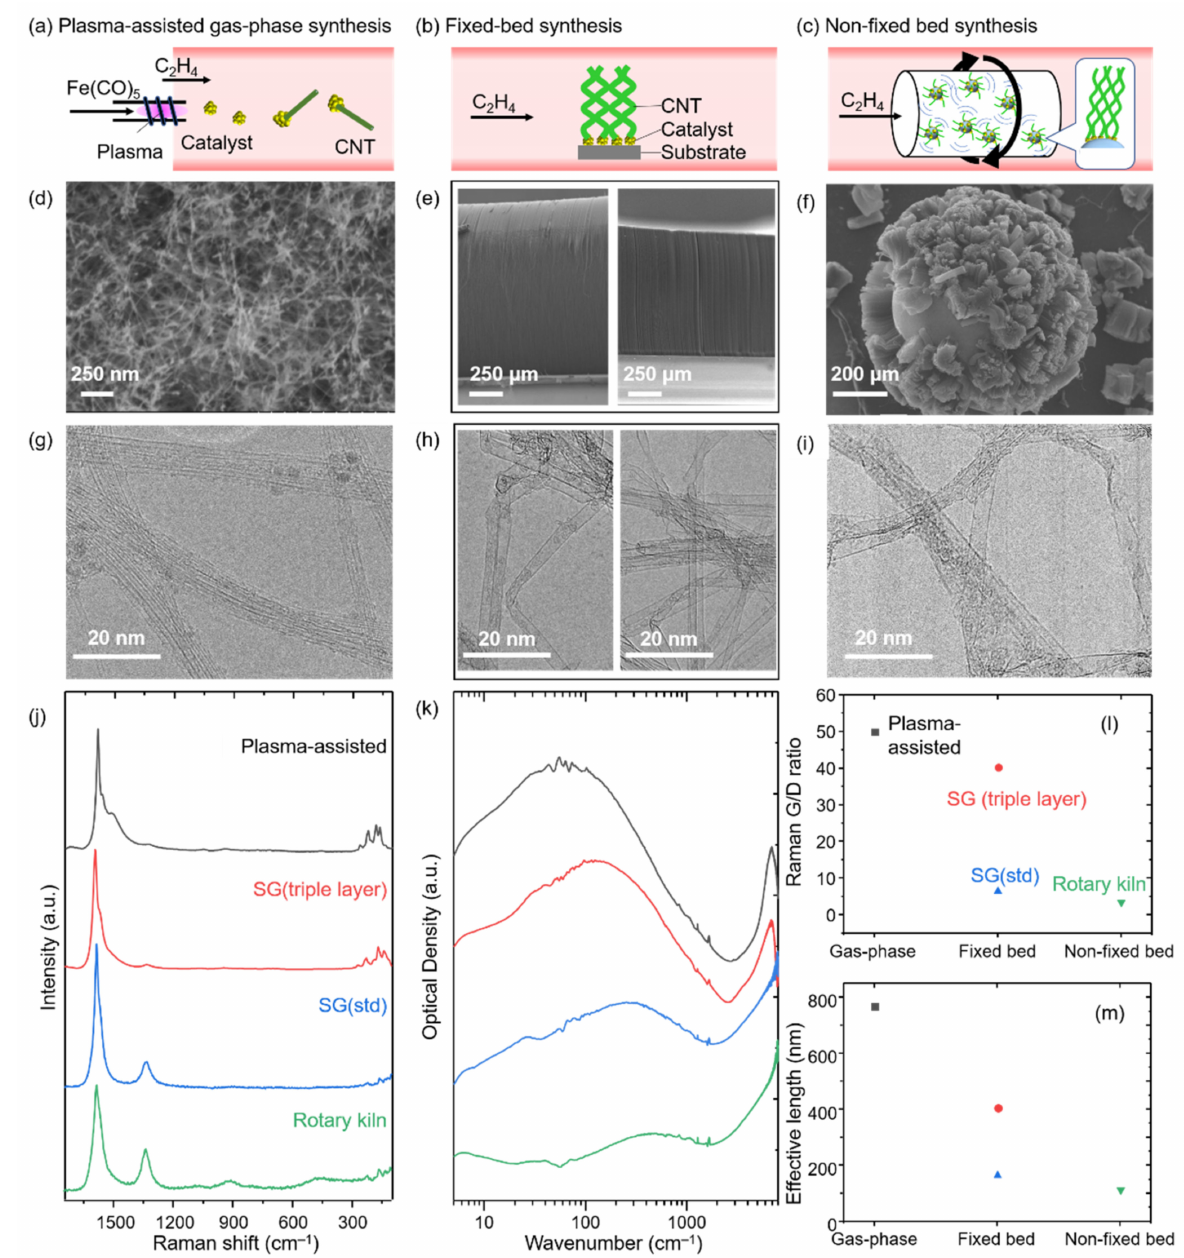
Figure 1. ( a – c ) Schematic illustrations of CNT synthesis processes. ( d – f ) SEM and ( g – i ) TEM images of the products produced by plasma-assisted gas-phase, fixed bed (triple-layer catalyst and standard catalyst) and non-fixed bed (rotary kiln) processes, respectively. ( j ) Raman and ( k ) FIR spectra of plasma-assisted gas-phase synthesized CNTs (black), SG (triple layer) (red), SG (std) (blue), and rotary kiln synthesized CNTs (green). Plots for ( l ) Raman G/D ratio and ( m ) effective